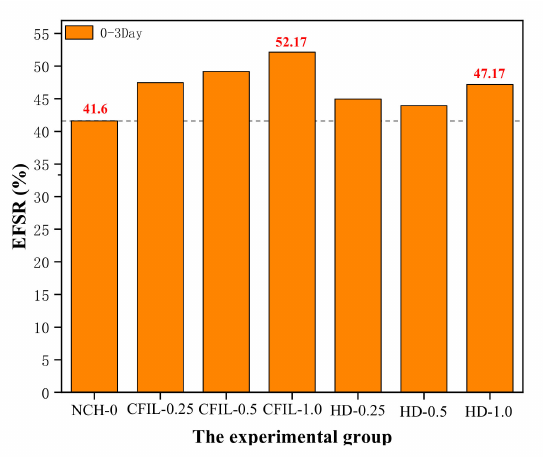
Figure 13. Early strength ratio of FS (EFSR) for each experimental group.